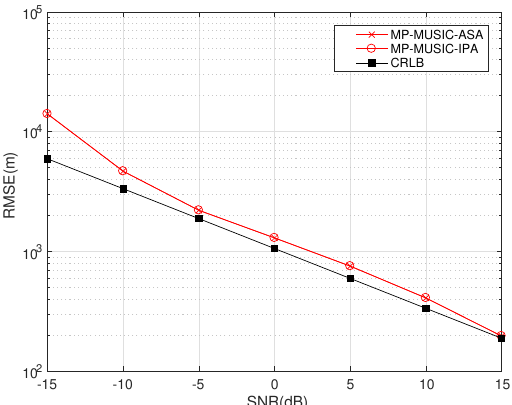
Figure 9. Performance of MP-MUSIC-Active Set Algorithm (ASA) and MP-MUSIC-Interior Point Algorithm (IPA).